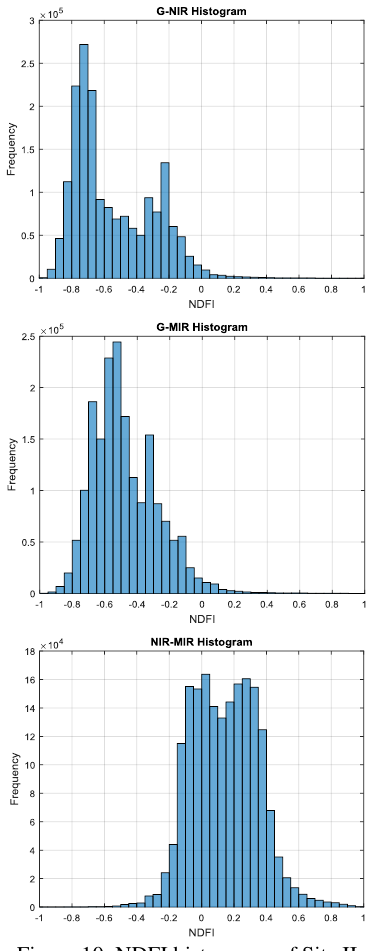
Table 5. Confusion matrix of labelled point based on NDFI G-MIR and number of returns in Site I